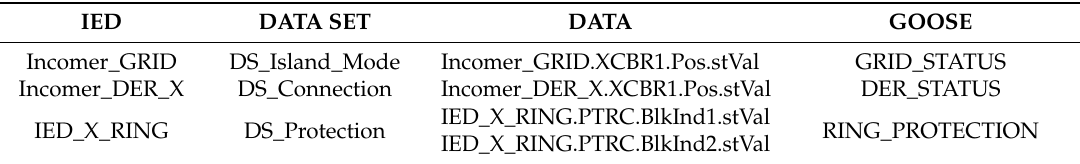
Table 2. DS Information for each IED.